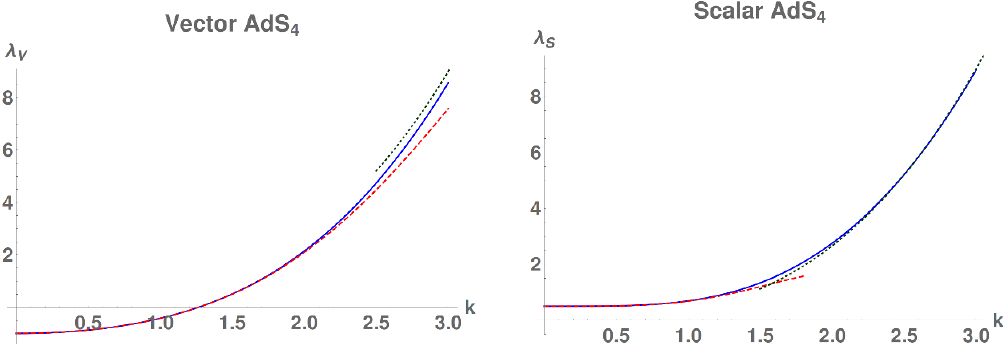
Figure 2 . Love numbers (cid:21) V;S for black branes in AdS 4 as a function of the wavenumber k , in units (cid:22) = 1. Solid blue: numerical results. Dashed red: perturbative expansions in powers of k , eqs. (5.4), (5.5). Dotted green: large- k limit (4.4). The Love numbers (cid:21) V;S are dimensionless and k is measured in units of (cid:22) 1 = 3 = 4 (cid:25)T= 3. likely that Pad(cid:19)e approximants can interpolate e(cid:14)ciently at intermediate values of k ,